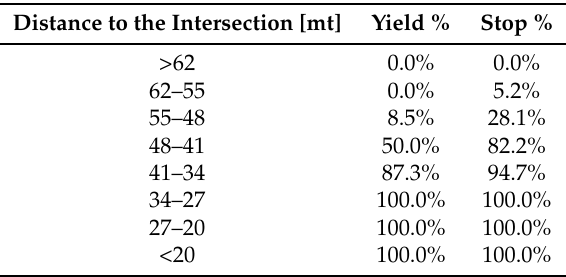
Figure 13. Comparison of detection rates versus distance between the Viola–Jones method and the statistical templates method for the stop and yield signs. Table 3. Detection rate based on the statistical template